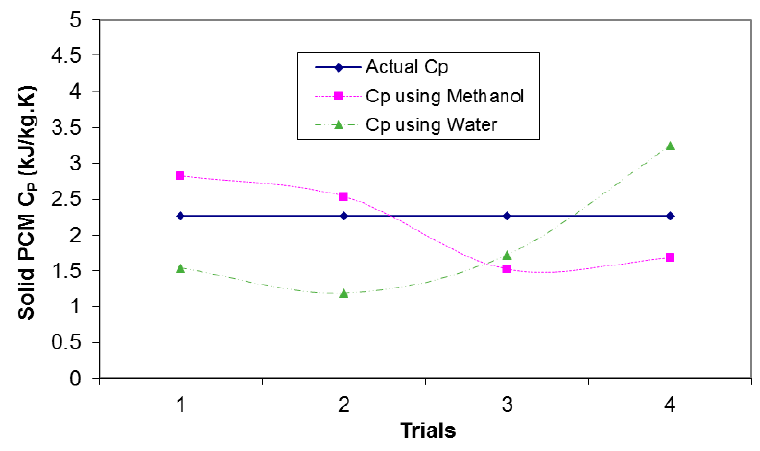
Figure 11. Comparison of the actual and measured specific heat capacity, C p , for solid Figure 11 . Comparison of the actual and measured specific heat capacity, 𝐶 (cid:3043) , for solid PCM